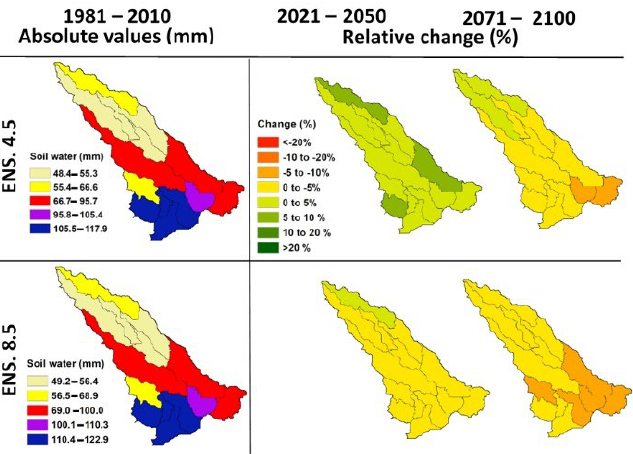
Figure 6. Catchment-scale distribution of annual average soil water content (SW) for the reference period (mm) and the relative change compared to the reference period (%) for each RCP.